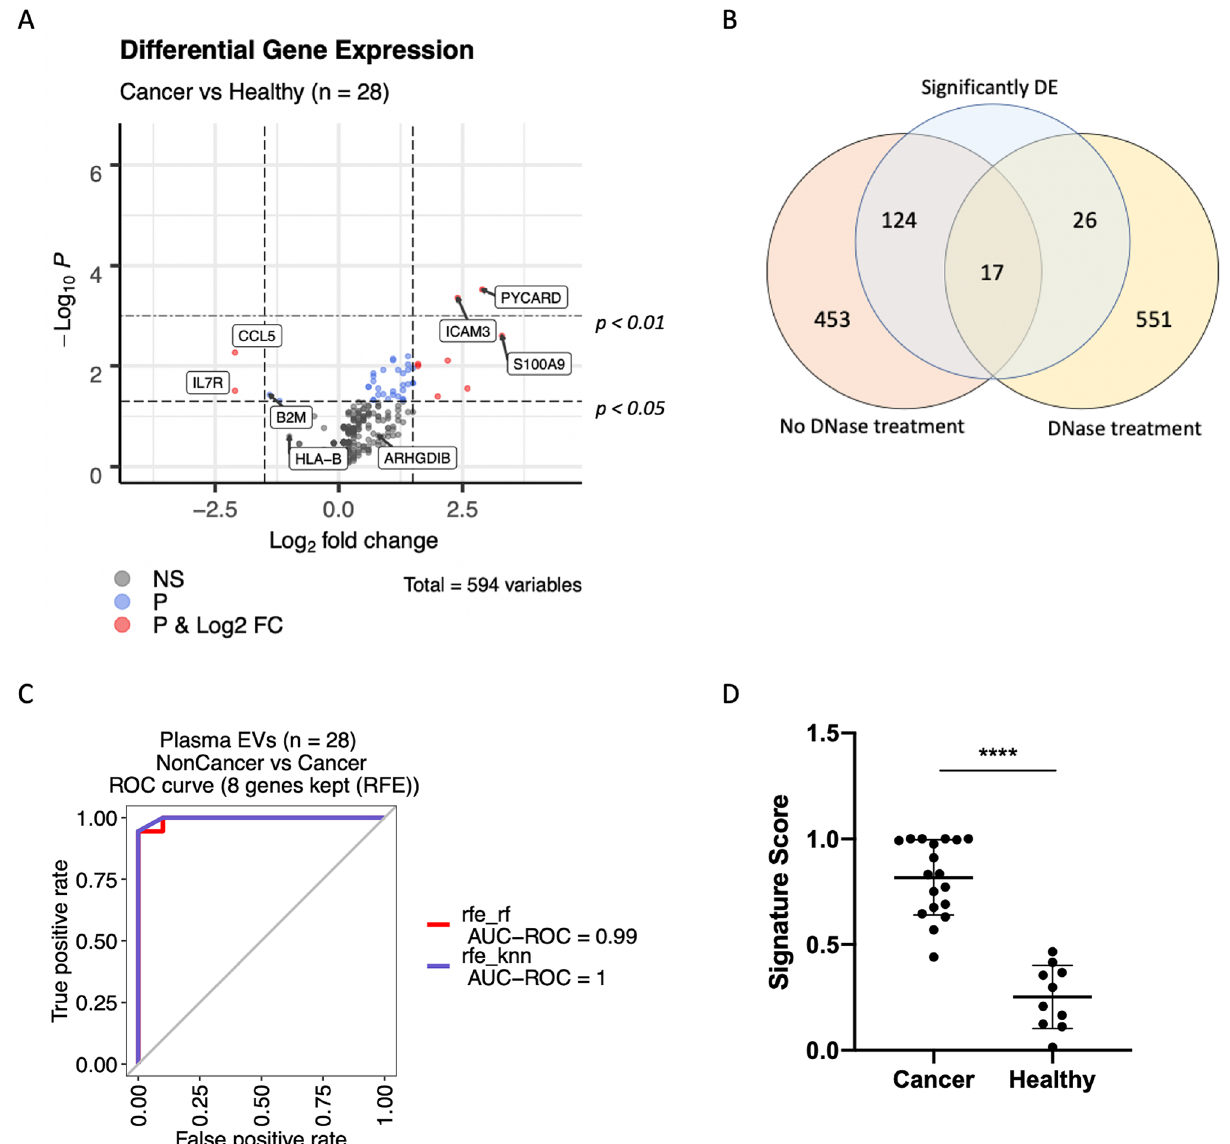
Figure 6. Effect of DNase treatment on differential expression analysis and classifier development. ( A ) Differential expression analysis of log2-normalized counts after DNase treatment between cancer patients and control samples. The full list of genes differentially expressed is presented in Supplementary Table S2. Labels indicate the eight transcripts selected for the final classification signature. ( B ) Out of 594 genes in the panel, 17 showed differential expression independently of DNase treatment. ( C ) Recursive feature elimination (RFE) was used to select an eight-gene signature that could distinguish between samples derived from cancer patients and controls. ( D ) Scores of cancer versus control samples based on expression of the eight gene signature (p < 0.001 in a two-tailed Mann–Whitney U test). DE, differentially expressed; EVs, extracellular vesicles; ROC, receiver operating characteristic; AUC, area under the curve; RFE, recursive feature elimination; rf, random forest; knn, k-nearest cancer patients. A previous study found that PYCARD could suppress apoptosis of cancer cells in gastric cancer 34 , potentially explaining the observed higher expression in EVs from cancer patients. Two studies have used nCounter for analysis of mRNA isolated from blood. Kossenkov et al 23 developed a pulmonary node classifier to differentiate malignant from non-malignant nodules previously detected by low- dose CT. Since the authors made use of whole blood, the quantities of purified RNA were significantly higher than those in our EV-based study (3 μg/2.5 mL blood versus 0.01 μg/2.5 mL, respectively), avoiding the need for a pre-amplification step. Beck et al 21 used a combination of CTC-RNA and cfRNA to profile tumor-associated biomarkers and correlate them with diagnostics and survival. The quantities of RNA were similar to those obtained in our study and a pre-amplification step was also added.